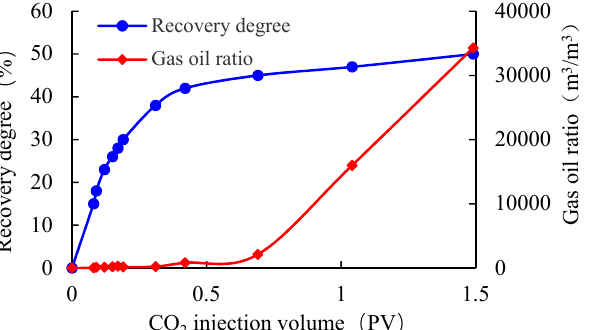
Figure 15. The relationship between CO 2 injected volume and recovery degree, gas oil ratio (Scheme 2).